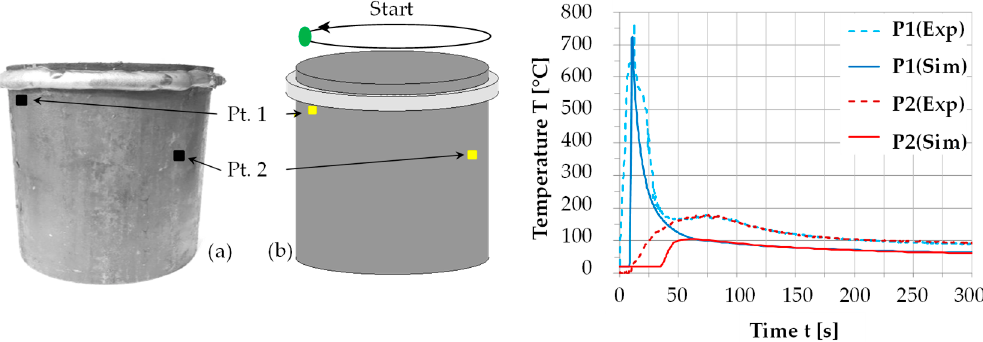
Figure 17. Thermal history of different points on the tool in the experiment ( a ) and the simulation ( b ). After cooling, a 7 mm disk-shaped specimen was cut out of the tool with a metal- cutting saw and finished for stress measurement using a hole-drilling machine PROTEC (Protec GmbH, Ottobrunn, Germany). A hole diameter of 1.7 mm and a hole depth of 0.6 mm were achieved during the drilling, as detailed in Section 2.3.2. The residual stresses along the radial and theta directions were measured at point P of the specimen (see Figure